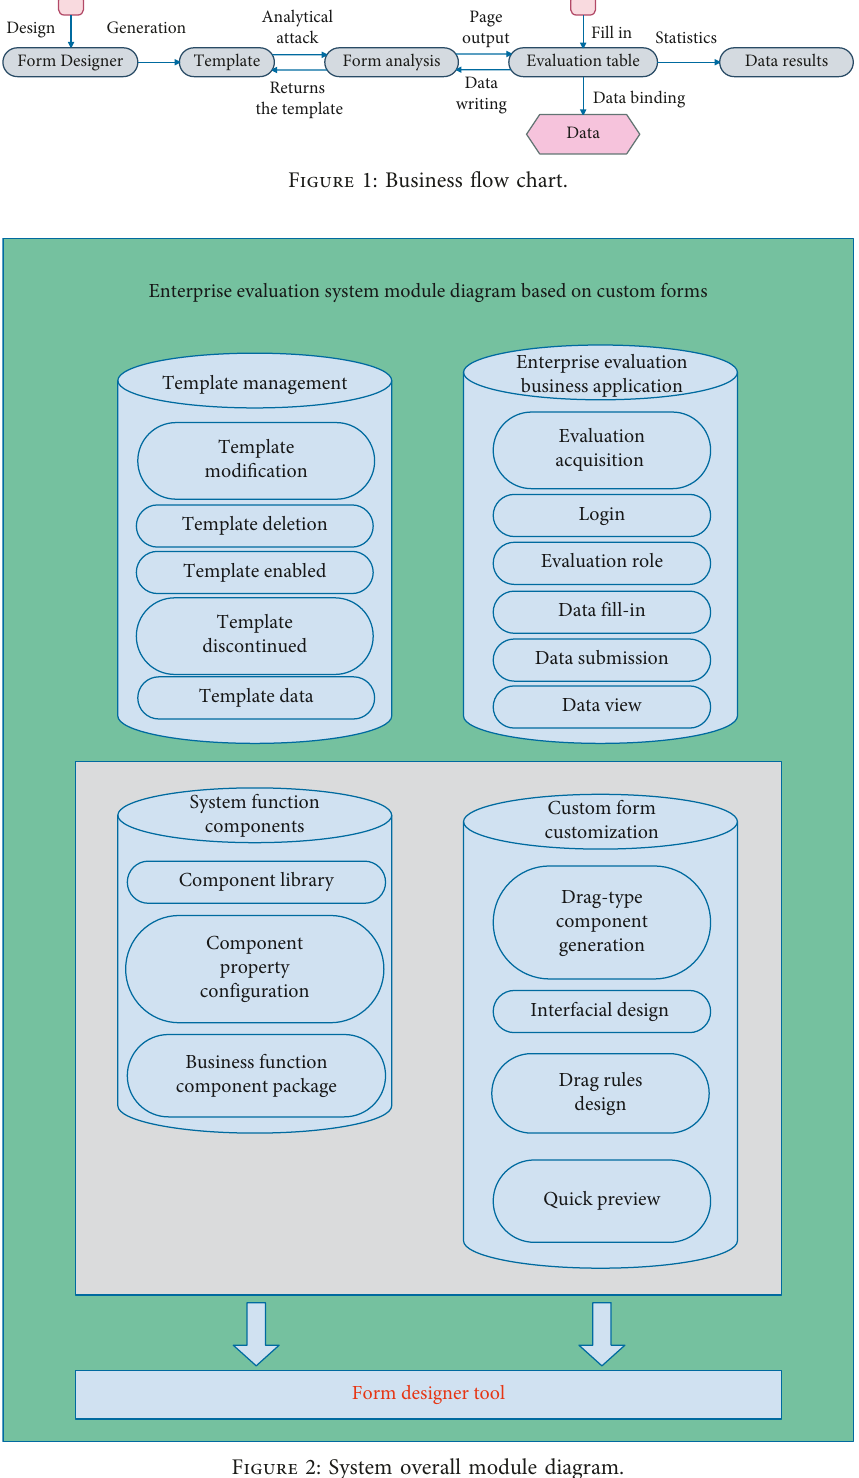
Figure 2: System overall module